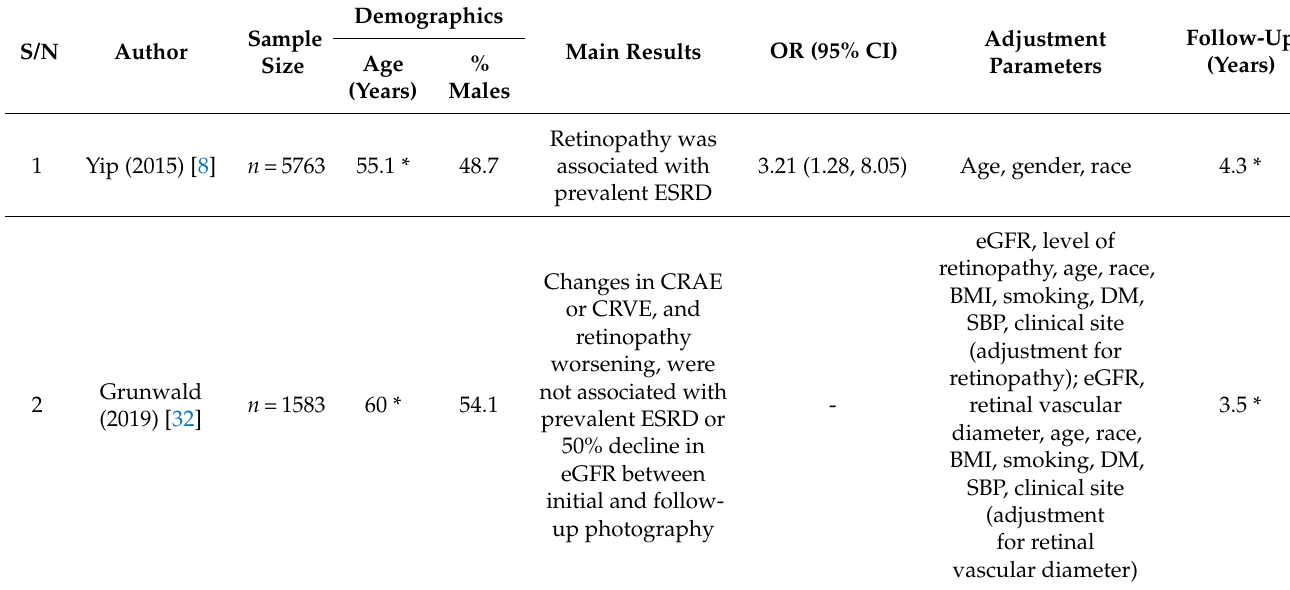
Table 4. Retinal microvascular signs and prevalent ESRD.